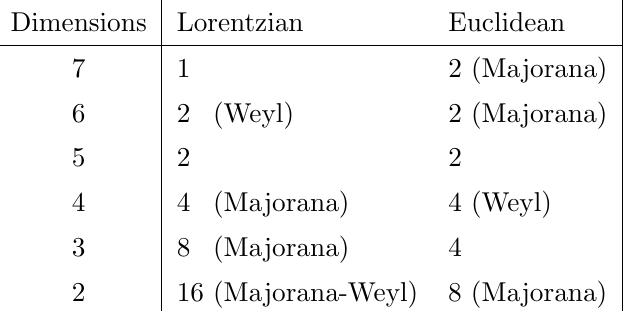
Table 1 . Number of minimal spinors in each dimension used in Lorentzian and Euclidean (cid:12)eld theories. The conditions the spinors satisfy are indicated in brackets. In all cases we denote the collective 16-component fermion with the symbol